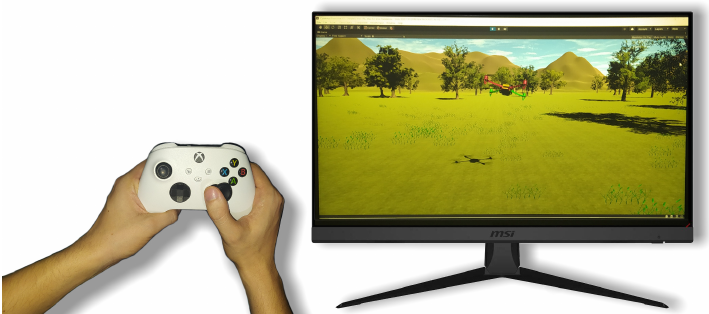
Figure 11. Final setup of the realistic virtual simulator for the quadrotor teleoperation.